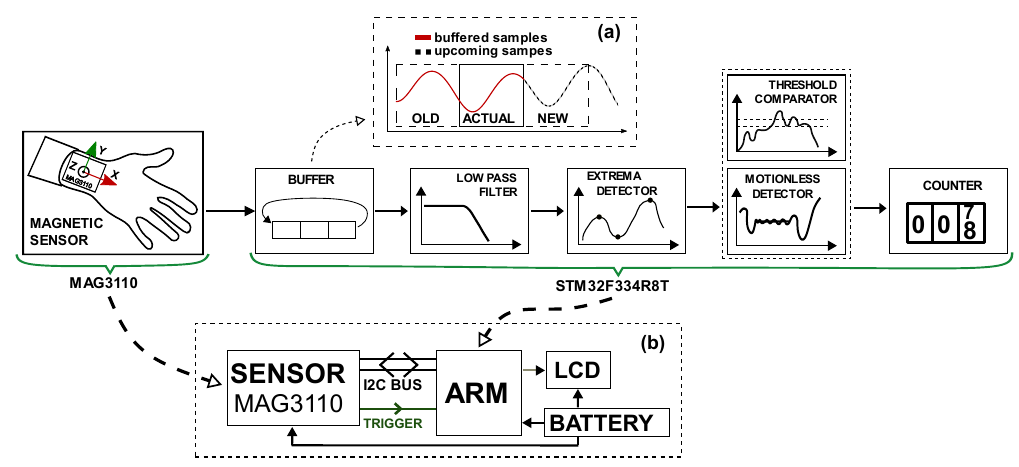
Figure 2. System hardware and functional blocks for data processing implemented in the microcontroller. Circular buffer memory section ( a ). System components: communication and power bus wiring ( b ).